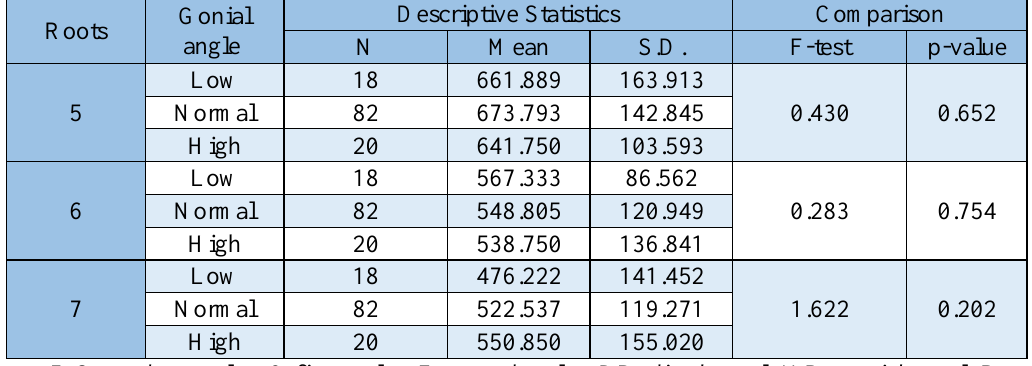
Table 6: Density of the sinus floor above root apices on CBCT according to gonial angle